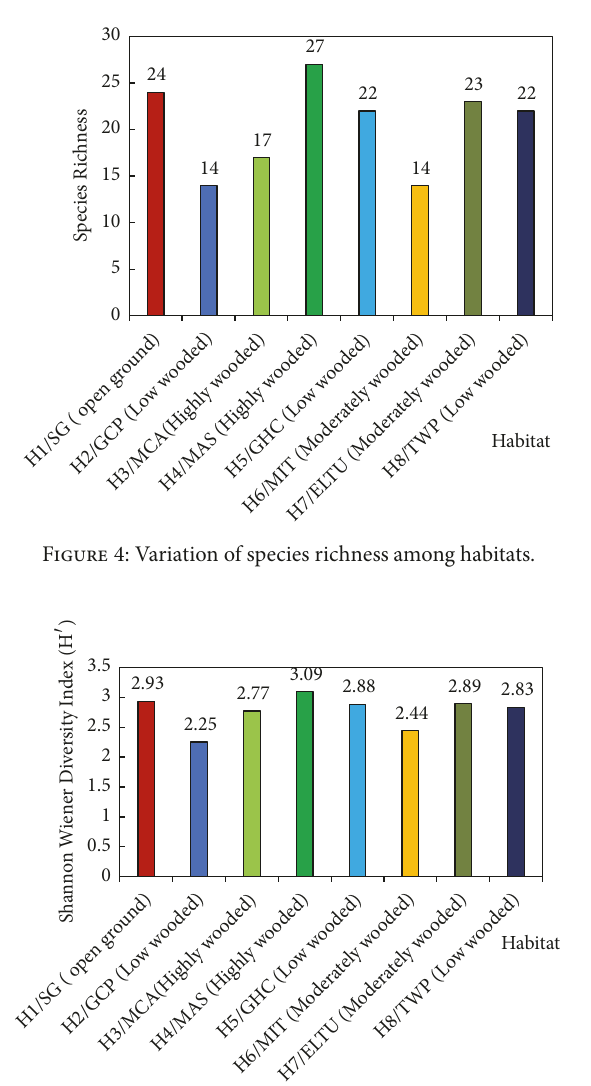
Figure 5: Variation of Shannon-Wiener diversity index (H’) in